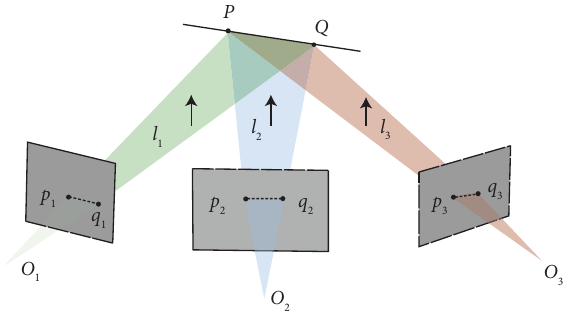
Figure 18: Te multifeature